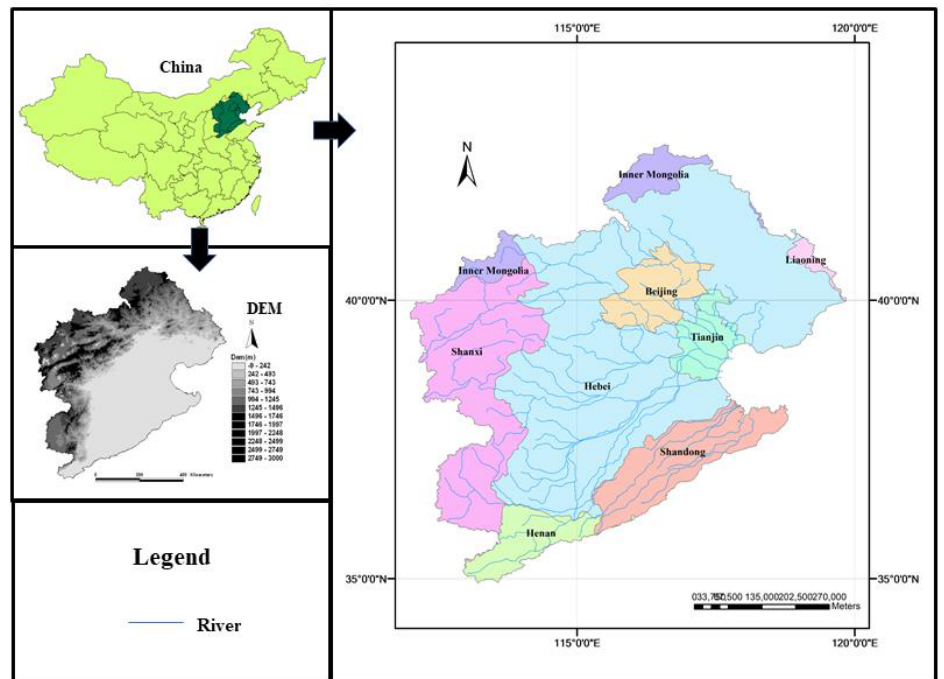
Figure 1. Map of the study area